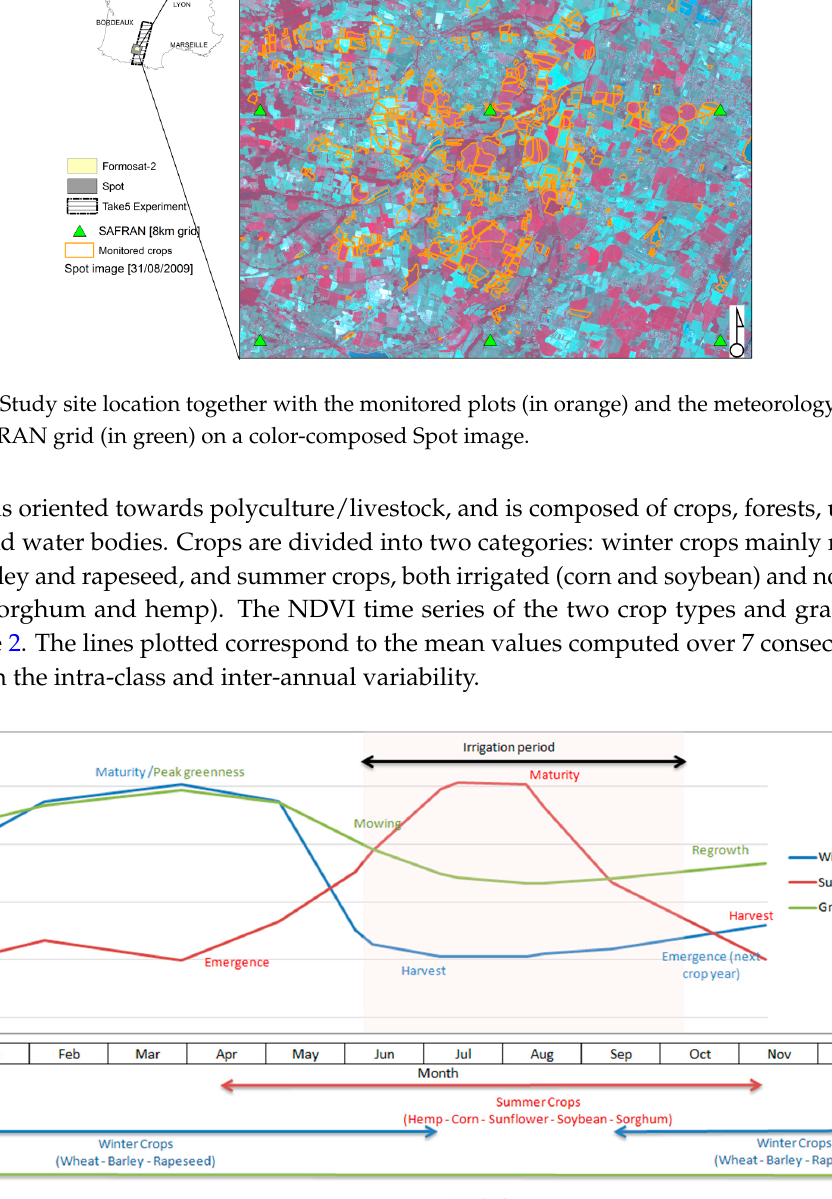
Figure 2. Mean annual Normalized Difference Vegetation Index (NDVI) phenological cycles (computed during the 2006–2013 period). The blue line represents winter crops and the red line summer crops. Grassland observations are in green.